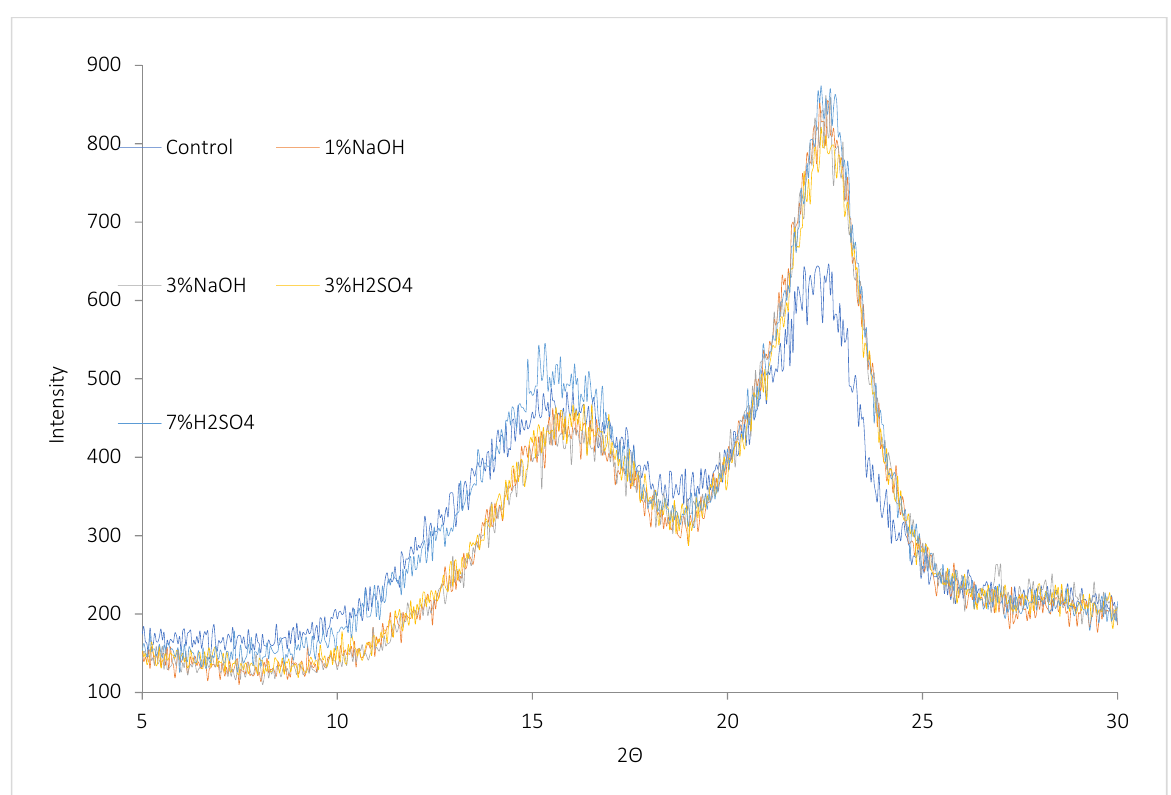
Figure 6. X-ray diffraction pattern of corncob cellulose before and after pretreatment.